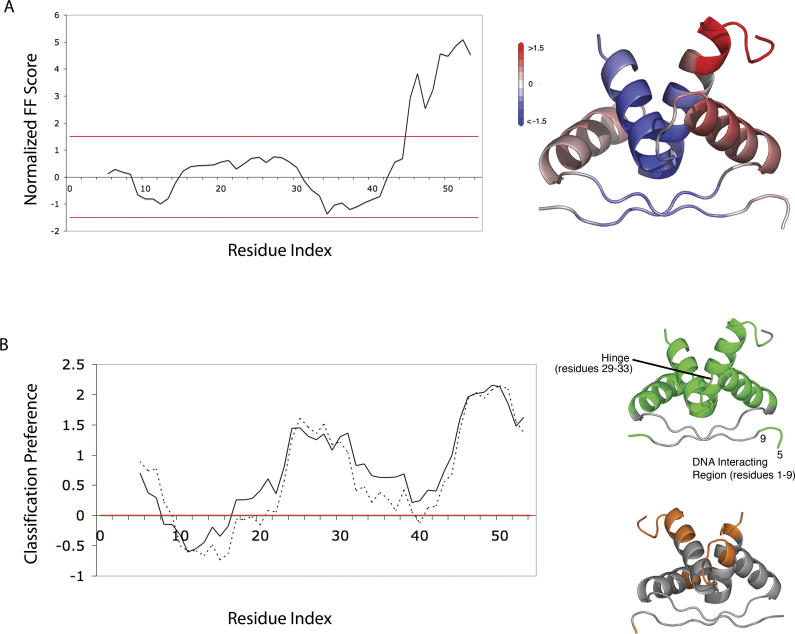
Performance of Wiggle Predictors on Arc Repressor(A) The dimer conformation of the Arc repressor was used to model global fluctuation. Using the FFR definition, the plot for a single chain is shown on the left with structural mapping of values onto a dimer on the right. FF scores are mapped with the gradient code from negative (blue) to positive (red). Only the C-terminal tail exceeds threshold lines (red) and is defined as an FFR while the rest of the protein is not. (PDB ID: 1BAZ)(B) The hinge between the two helices is identified by predictors as well as N-terminal residues important for DNA recognition. Predictions from Wiggle (solid line) are mapped in green on the structure and Wiggle200 (dashed line) are mapped in orange.